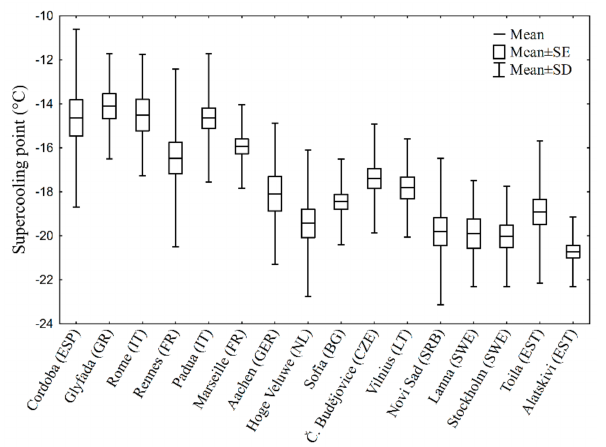
Figure 1. Distribution of supercooling points (SCPs) among populations (the localities are ordered by decreasing minimal winter temperature). See Table 1 for sample sizes.